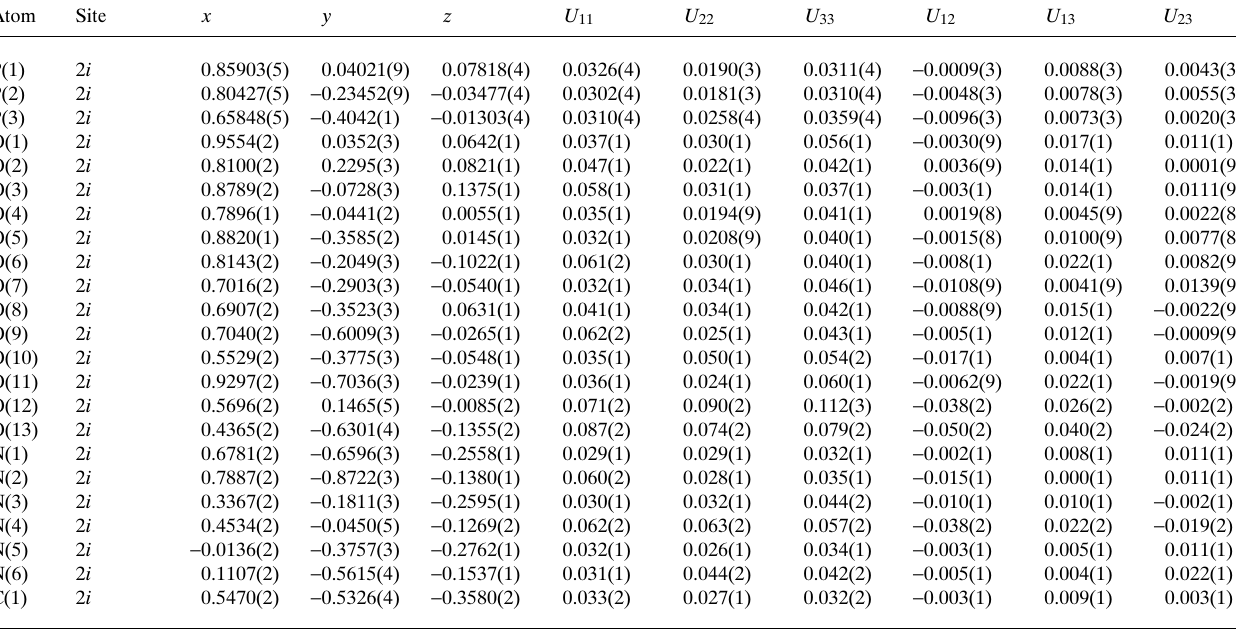
Table 3. Atomic coordinates and displacement parameters (in Å 2 ).